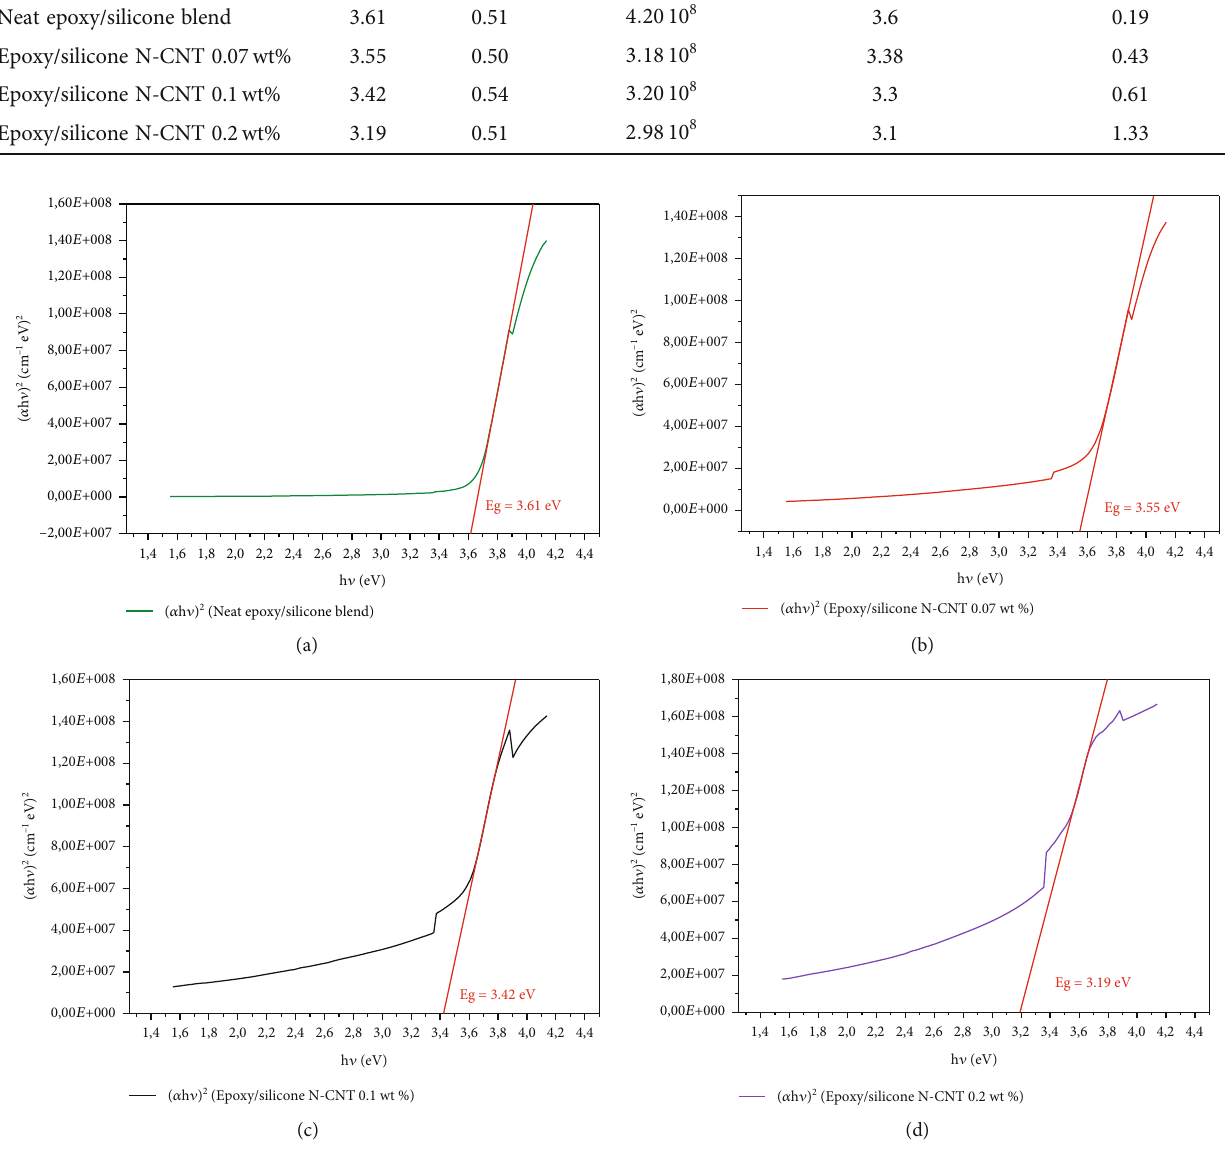
Figure 2: Plot of ð α hv Þ 2 versus photon energy hv , for “ epoxy/silicone N-CNT @ wt% ” ( @ = 0 : 00 , 0.07, 0.1, and 0.2).